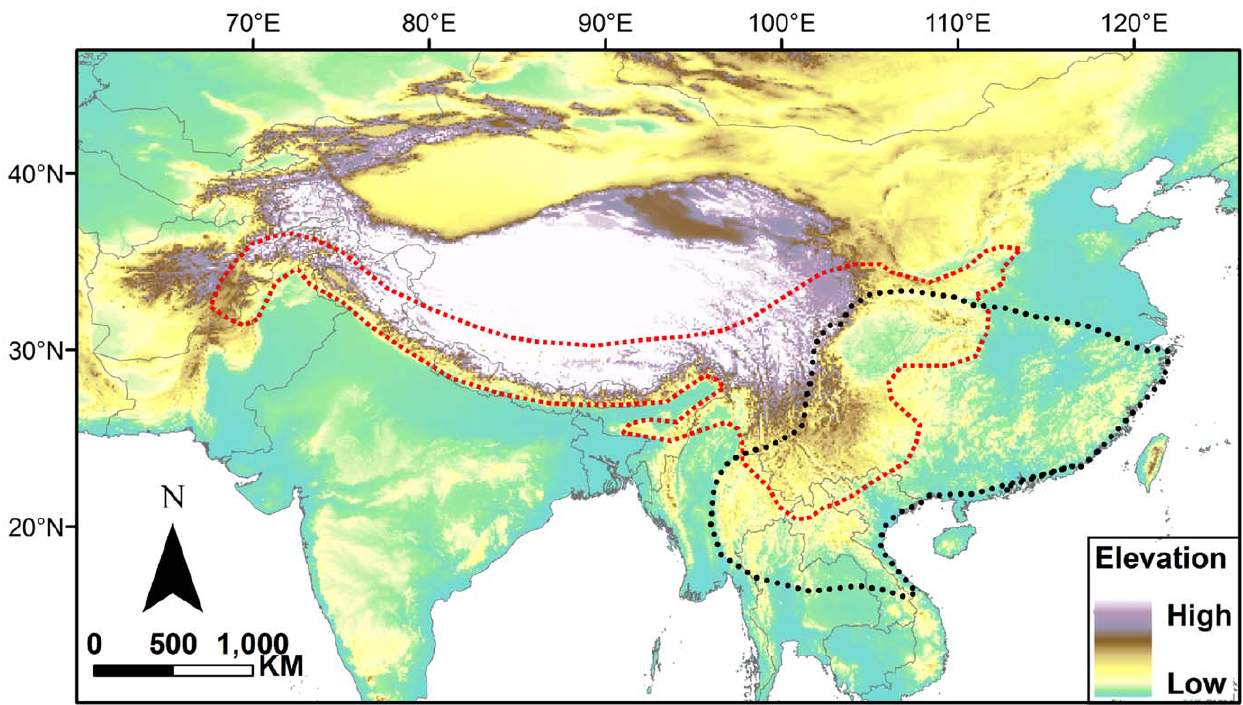
Figure 1. The sketch map of the study region in Asia. Current distribution ranges are indicated for the tribes Paini (red dotted line) and Quasipaini (black dotted line).